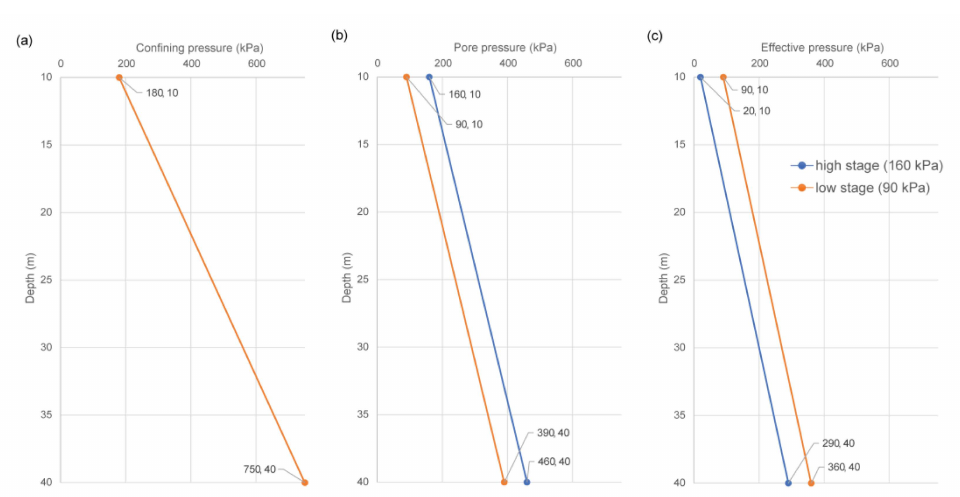
Figure 13. Stress distribution diagrams from borings and transient fluid flow model for confining pressure ( a ), pore pressure ( b ), and effective pressure ( c ) during low (6 m) and high river stages (13.5